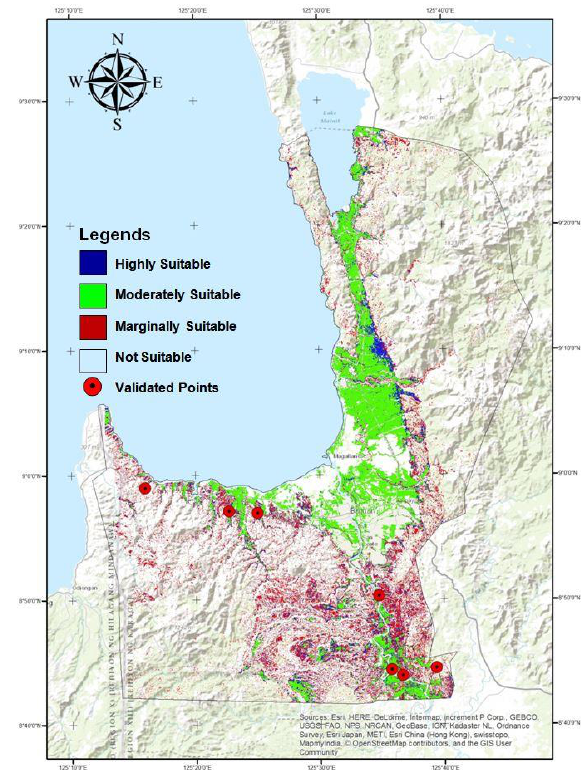
Figure 1. The generated SFR Suitability Map for Agusan del